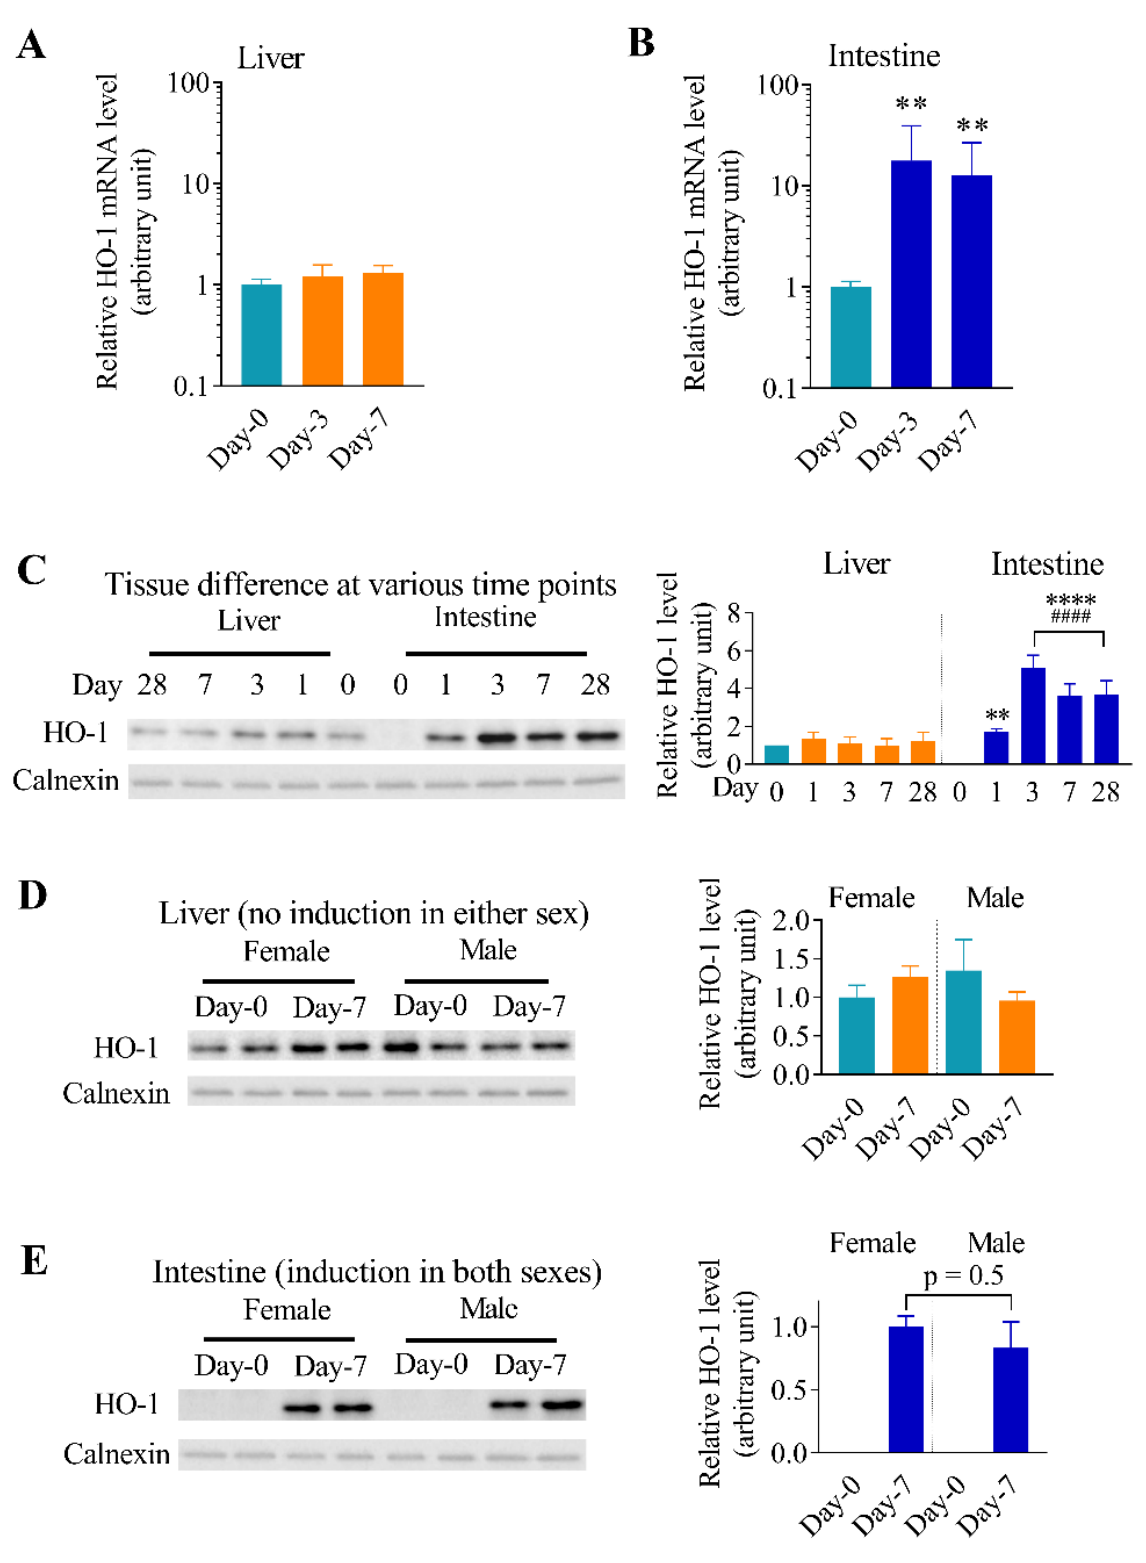
Figure 2. Differential effects of oral arsenic exposure on hepatic and intestinal HO-1 mRNA and protein expression. Mice (3–4-month-old, male or female) were exposed to 25 ppm arsenite via drinking water. Relative HO-1 mRNA levels (means ± S.D.) in the liver ( n = 3) ( A ) or small intestinal epithelial cells ( n = 6) ( B ) of male mice, normalized by GAPDH mRNA levels, are shown. **, p < 0.01 (Kruskal –Wallis test followed by Dunn’s multiple comparisons tes t); vs. Day-0. ( C – E ) Immunoblot